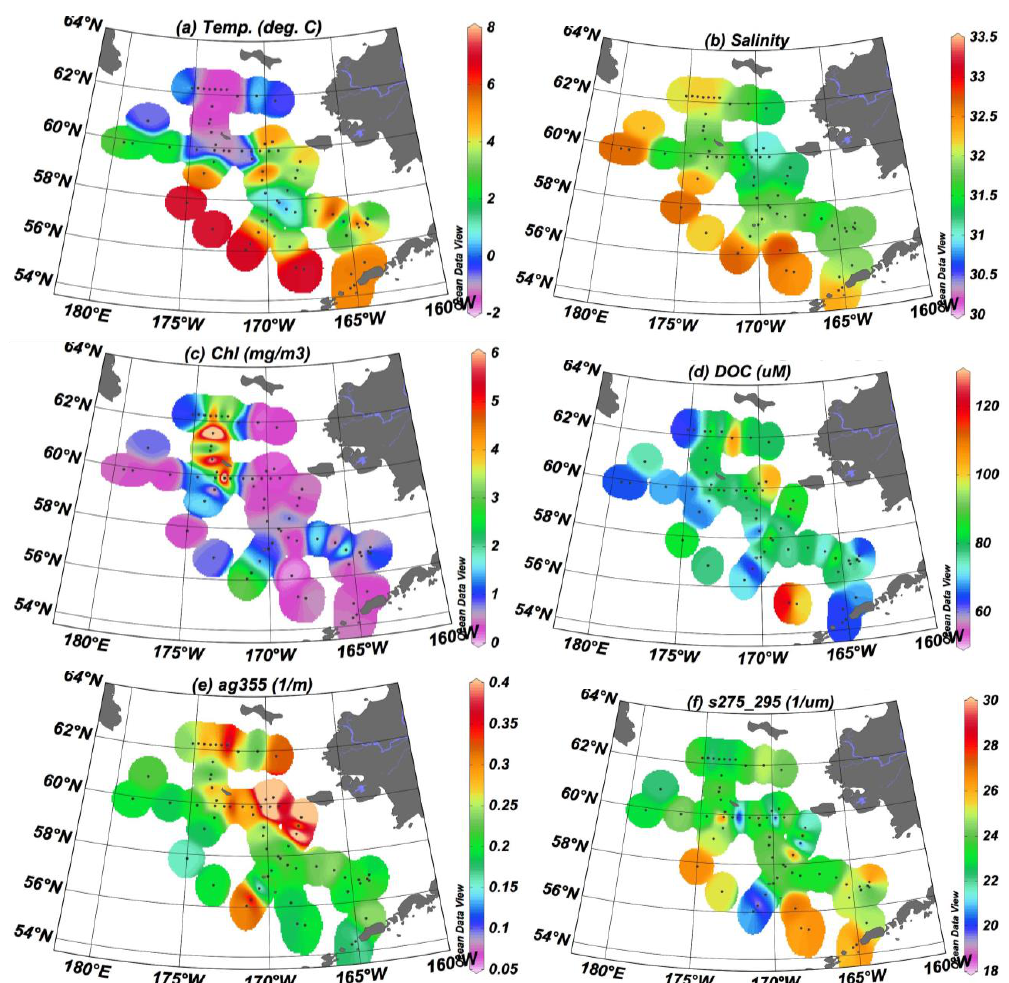
Figure 4. Spatial distributions of (a) temperature, (b) salinity, (c) Chl, (d) DOC, (e) a g 355, and (f) S at mid-1 depths ( ∼ 28m) corresponding to the Chl